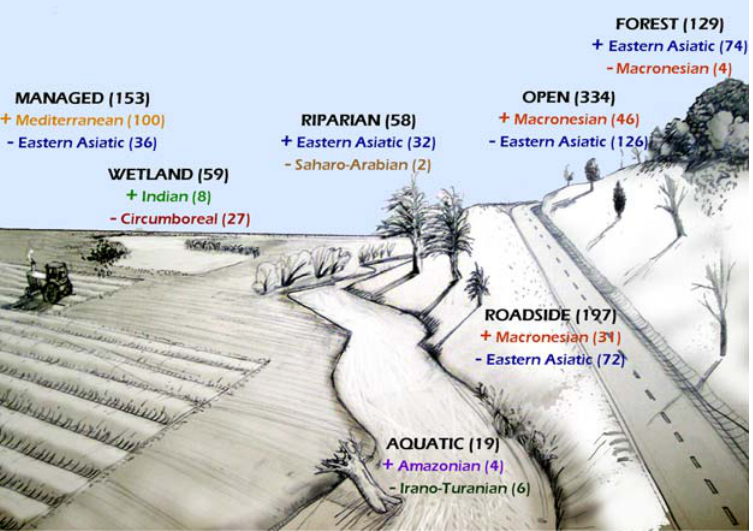
Figure 2. Floristic signature of Eastern U.S. plant invasions by habitat type. Seven habitat types (Table 1) are illustrated with the total number of species described as ‘‘invasive’’ (out of 449 total in the Eastern U.S.) listed in bold parentheses. Floristic regions most positively and negatively associated with each habitat were determined by the most extreme positive and negative standardized residual values from a Pearson chi- square test of a contingency table of all floristic regions and habitat types (Table 3). Number of invaders contributed to each habitat by each listed region are noted in parentheses. Drawing by Eric Fridley.